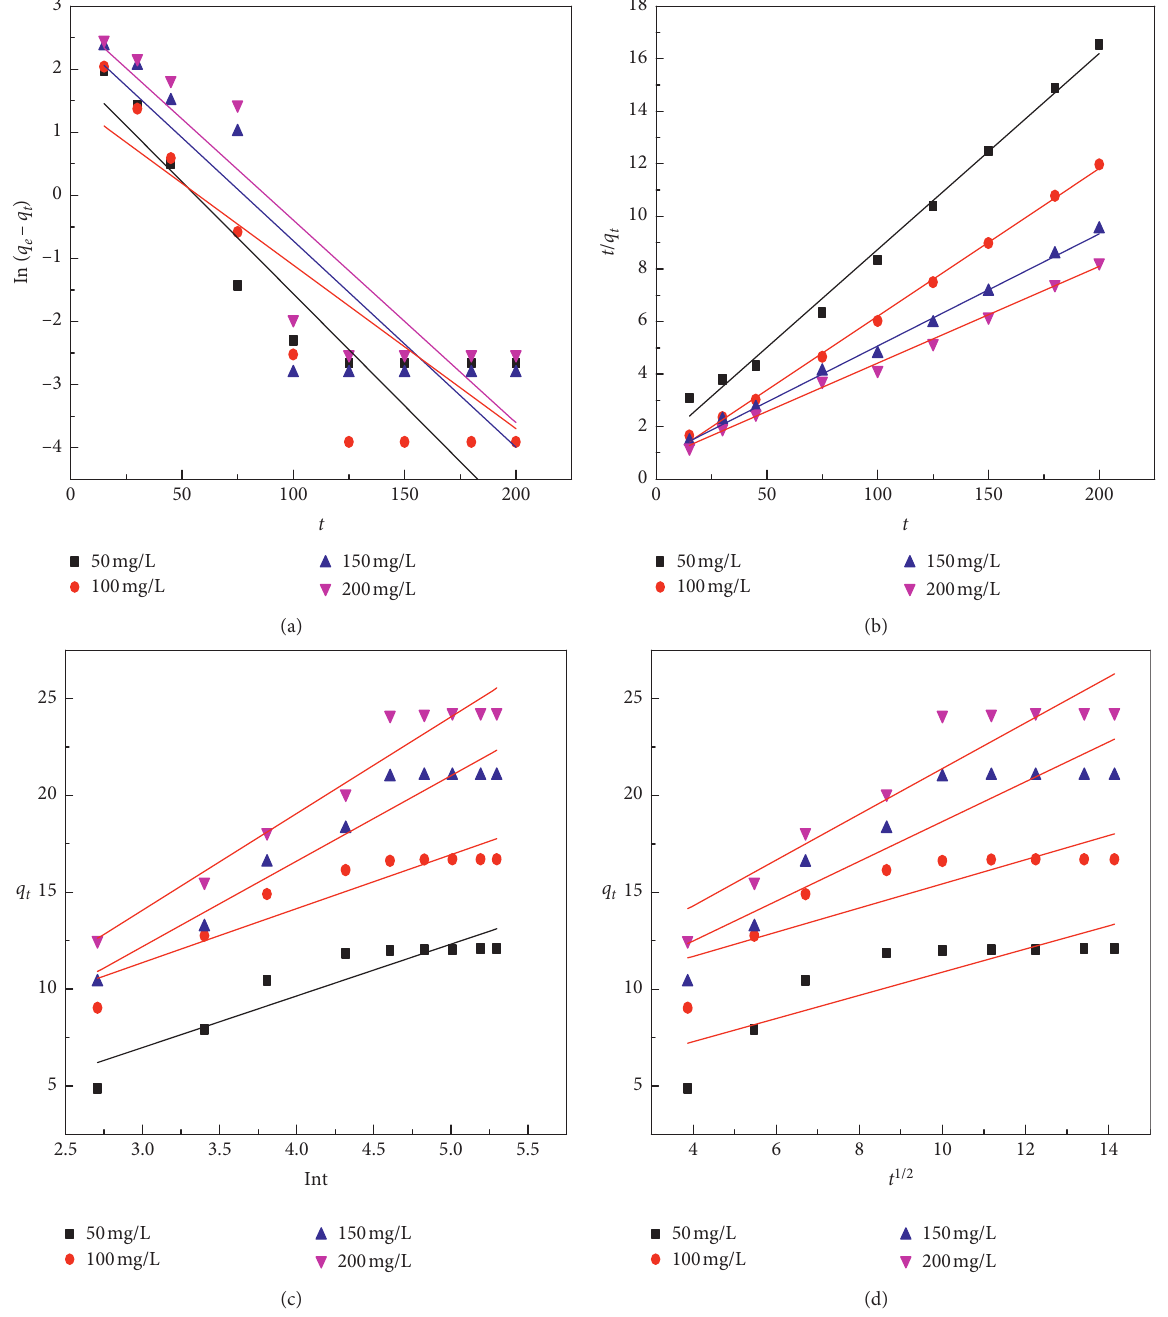
Figure 9: (a) pseudo-first-order, (b) pseudo-second-order, (c) Elovich equation model, and (d) intra-particle diffusion model kinetic plots for ammonia removal by EMRZ at different initial ammonium concentrations (EMRZ dosage � 0.2 g/100mL; pH value � 6.0; temperature � 25 °